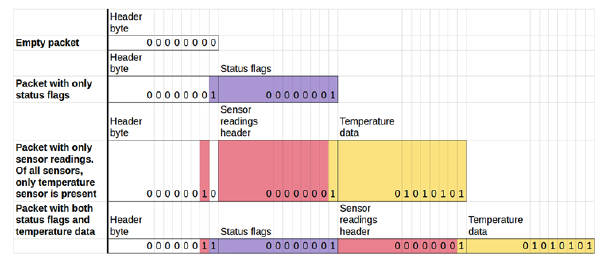
Fig. 4. The structure of the developed communication protocol.